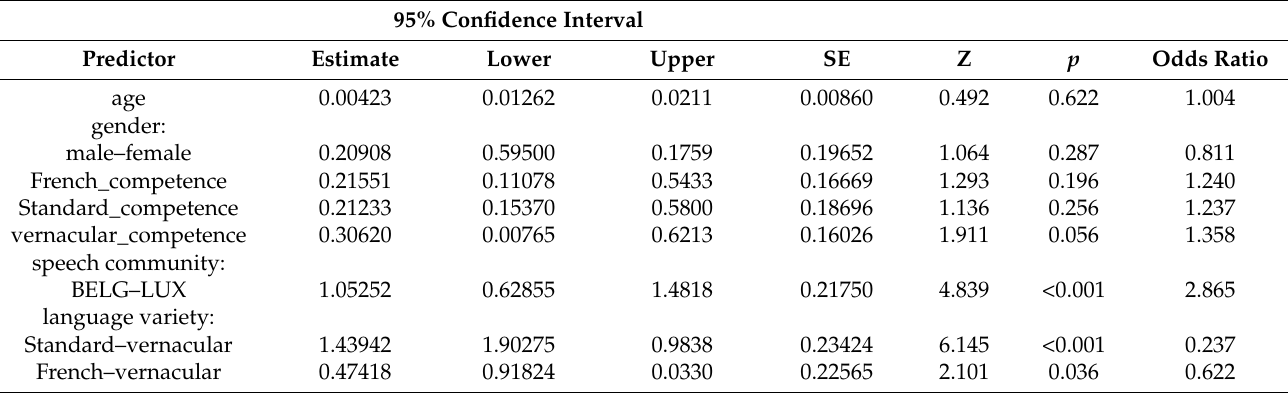
Table 2. Model coefficients: outcome variable: AtoL_Score; R 2 = 0.02 (Cox and Snell), 0.06 (Nagelkerke). Model χ 2 (8) = 75.1, p < 0.001